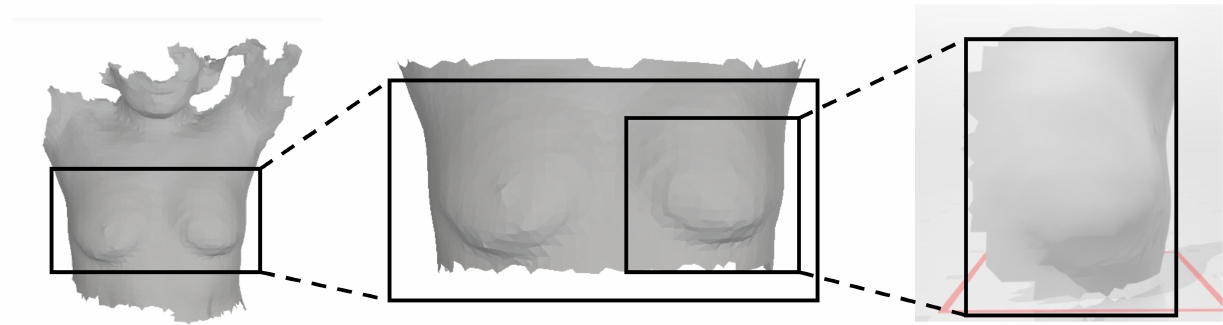
Figure 3. A 3D scanned model of the breast.